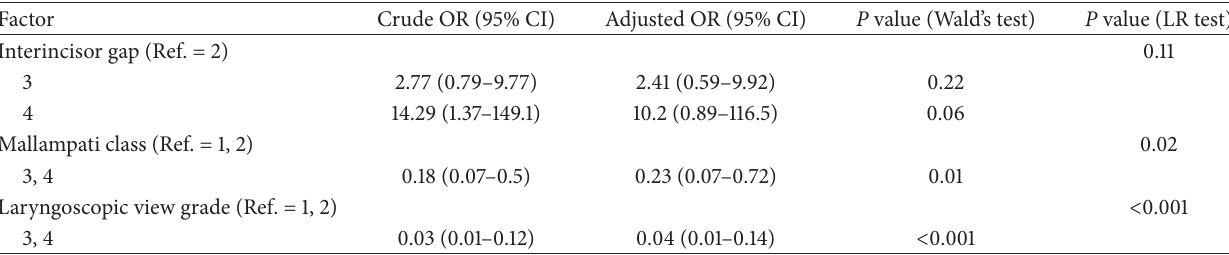
Table 2: Significant patient factors for successful intubation.